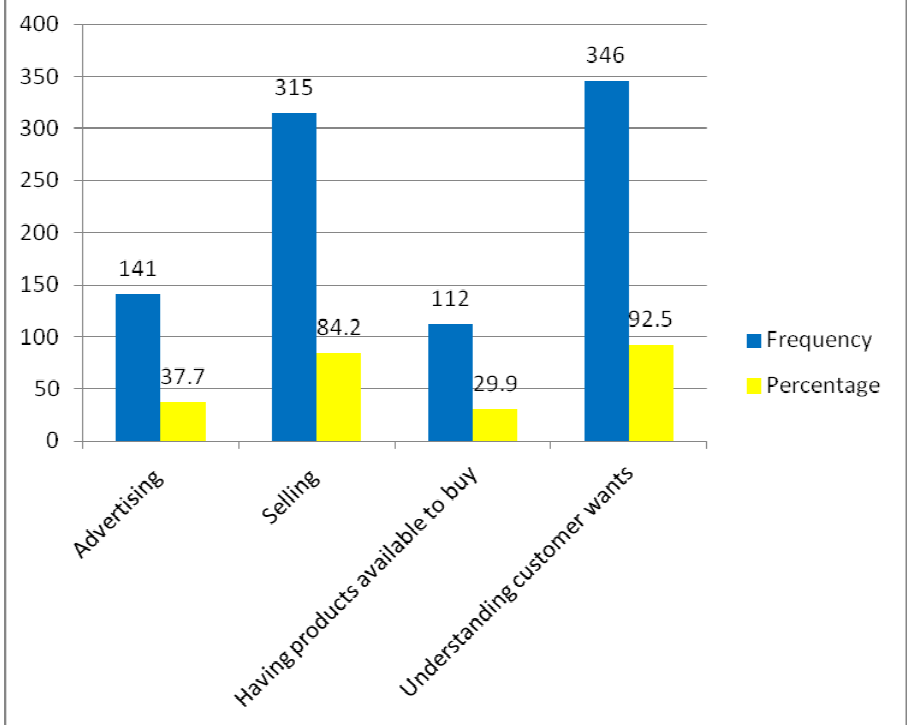
Figure 1: The understanding of the respondents about what marketing is Understanding what customers want and selling of products (92.5% and 84.2% respectively) was seen to be what marketing is. Fewer respondents understood that marketing also includes advertising and having products available for people to buy (37.7% and 29.9%